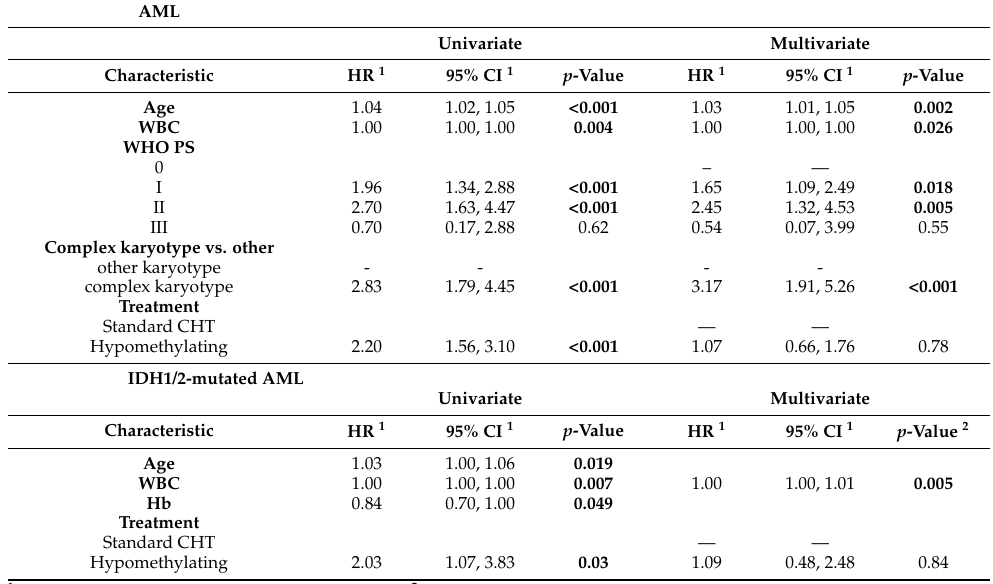
Table 2. Multivariate models for OS in the whole population of study and in the subset of IDH1 / 2 mutated